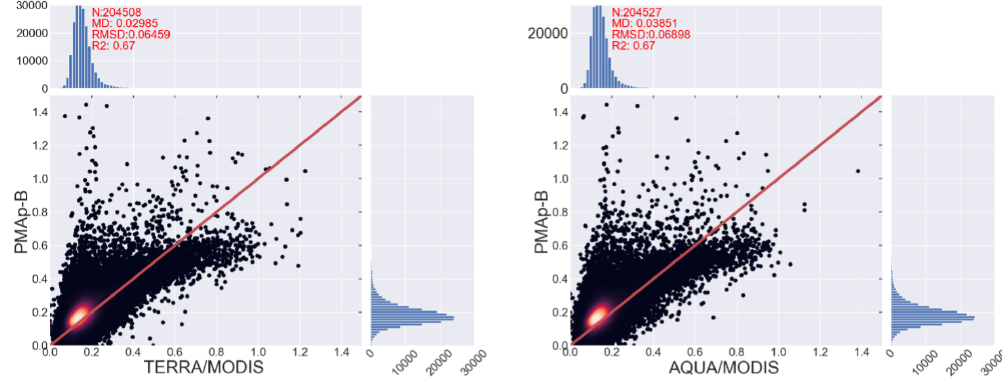
Figure B5. PMAp-B vs. MODIS AOD scatter plots of temporal mean AOD over ocean for the DJF period.